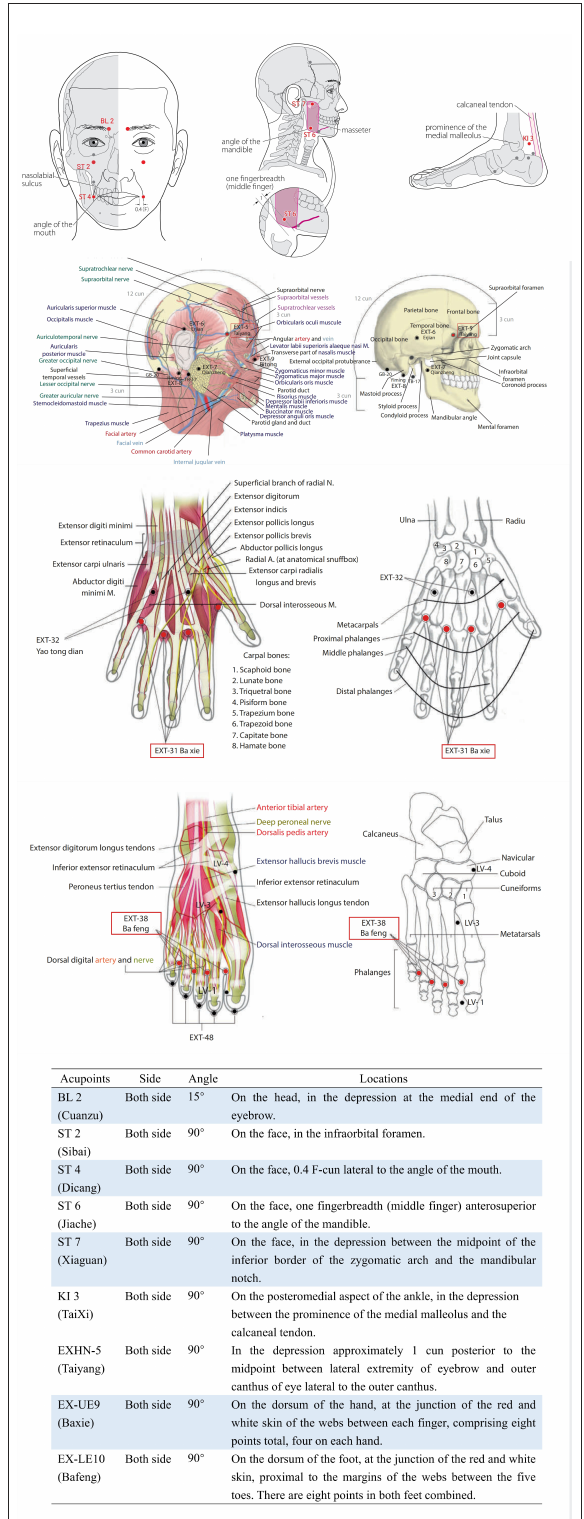
FIGURE3 The locations of acupoints (16,